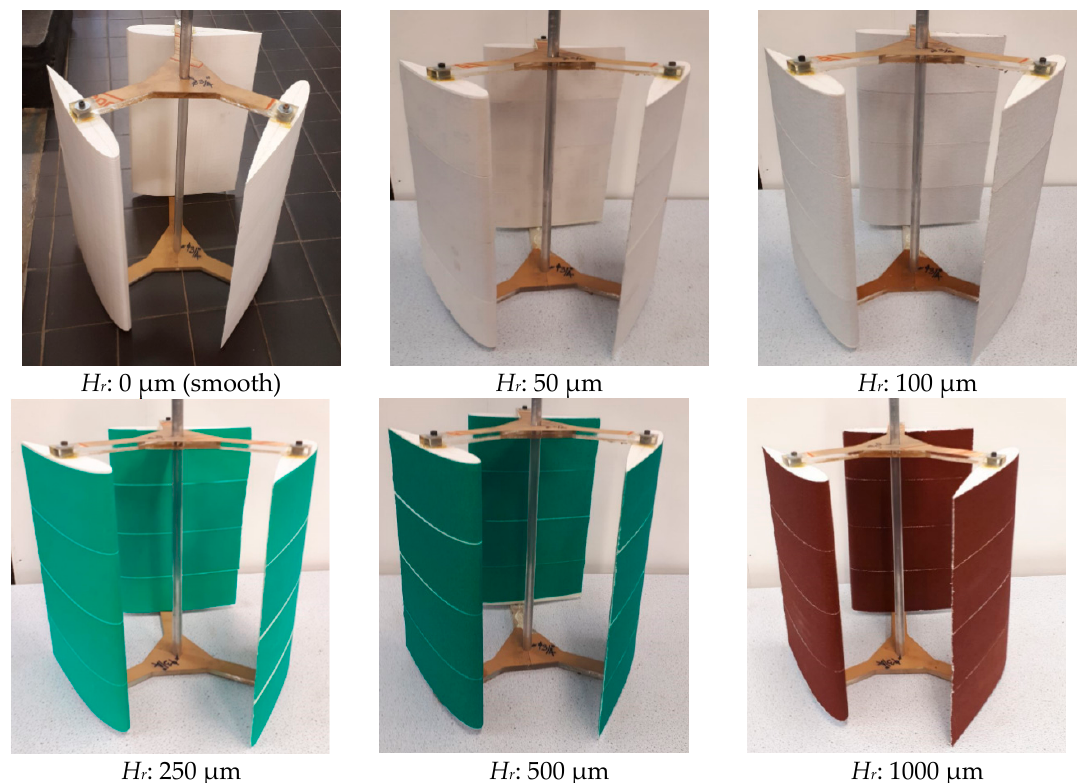
Figure 15. Experimental cases with different roughness values.